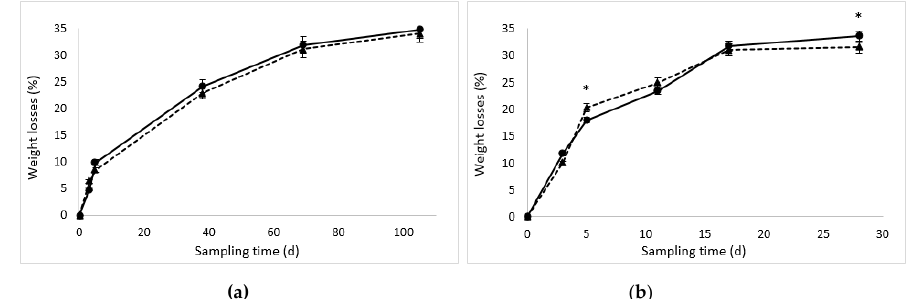
Figure 2. Weight losses (%) with respect to the initial weight during fermentation and ripening of the sausages inoculated with the two different starters: ( a ) large diameter and ( b ) small diameter. The dotted line with the triangles represents the inoculated samples with L. sakei / S. xylosus while the continuous line with circles represents the inoculated samples with P. pentosaceus / S. xylosus . An asterisk indicates the presence of significant differences between starters for each sausage size and each sampling time.